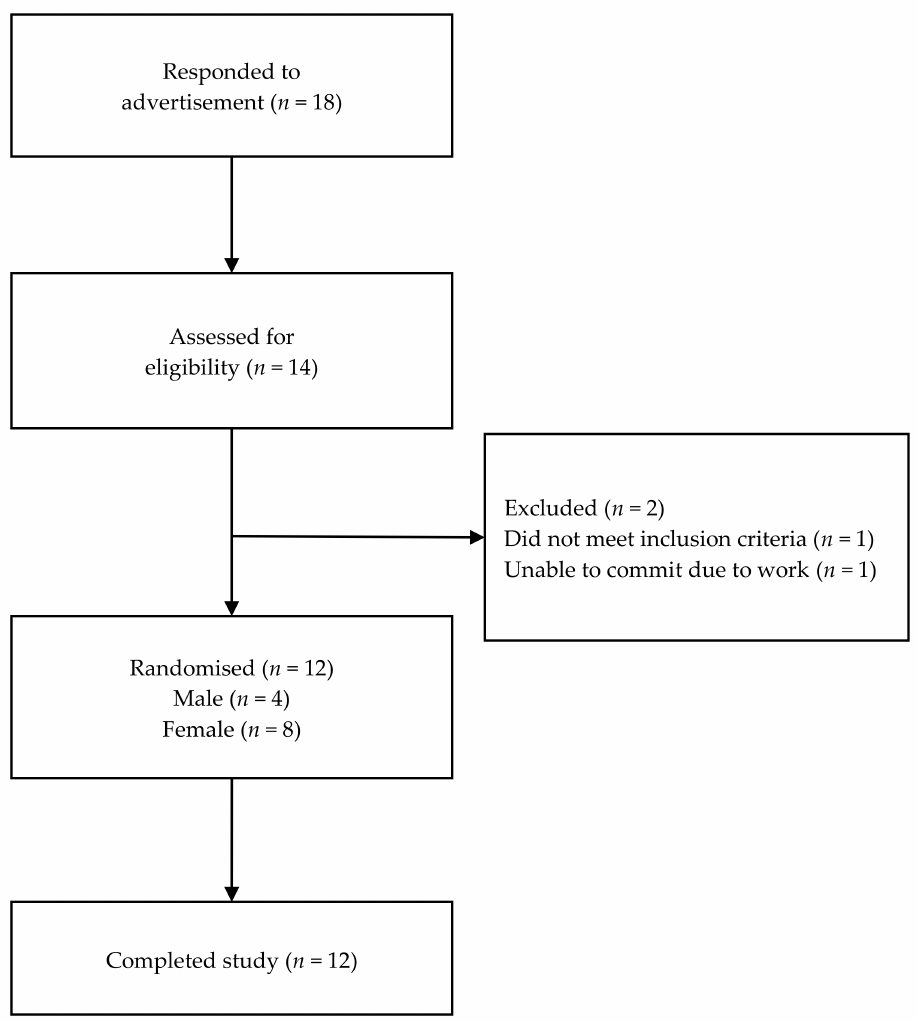
Figure 1. Flow diagram describing the progress of the subjects through study (P1).